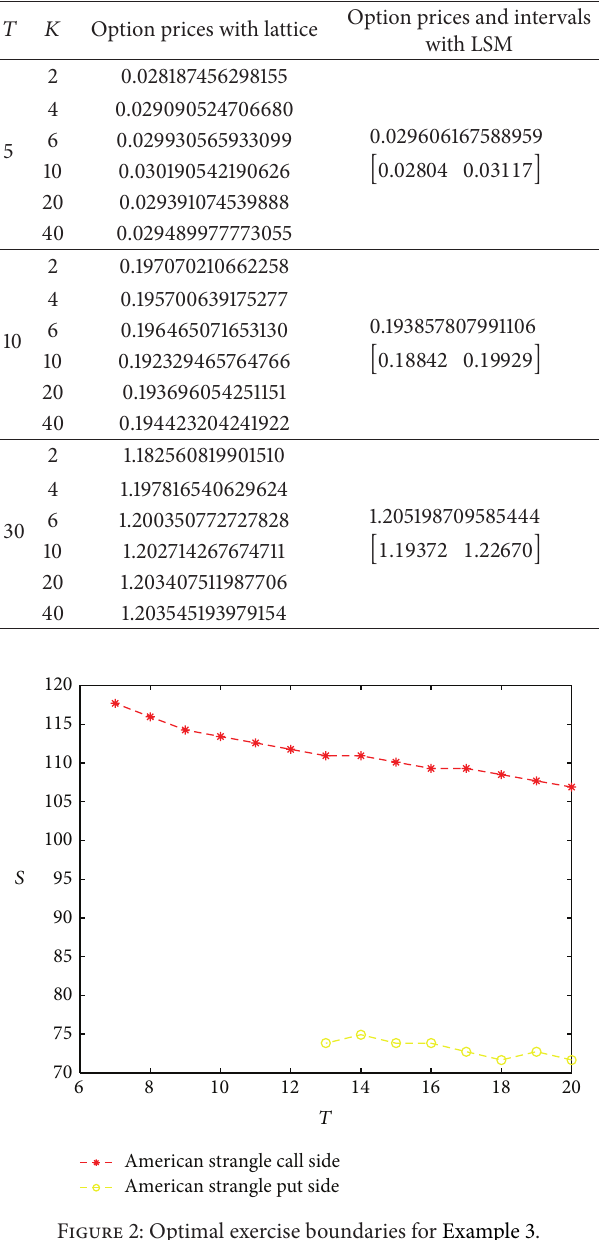
Table 4: Numerical results for Example 4.